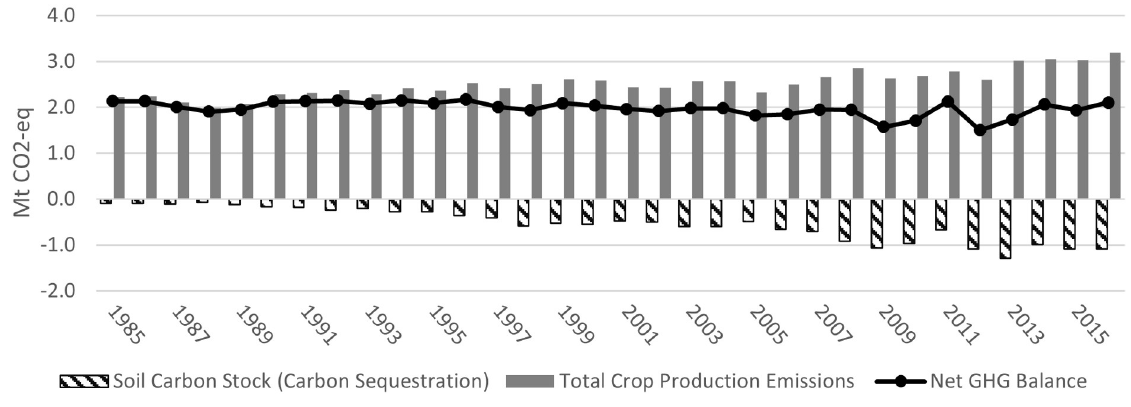
Fig 5. Manitoba GHGs estimates in the crop sector (Mt CO2-eq) (1985–2016).